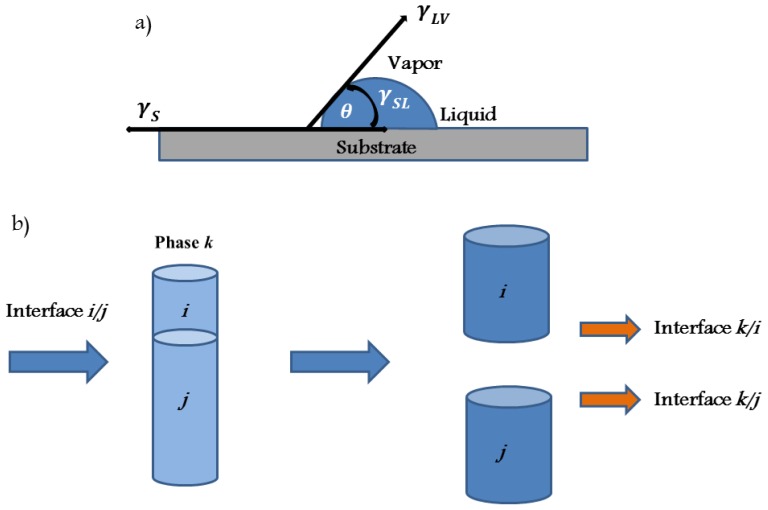
(a) Schematic representation of a liquid drop on a solid surface. Equilibrium is characterized by the three surface tensions acting at the liquid (i): solid, (j): vapor, (k): contact line [211]; (b) The separation of two phases.